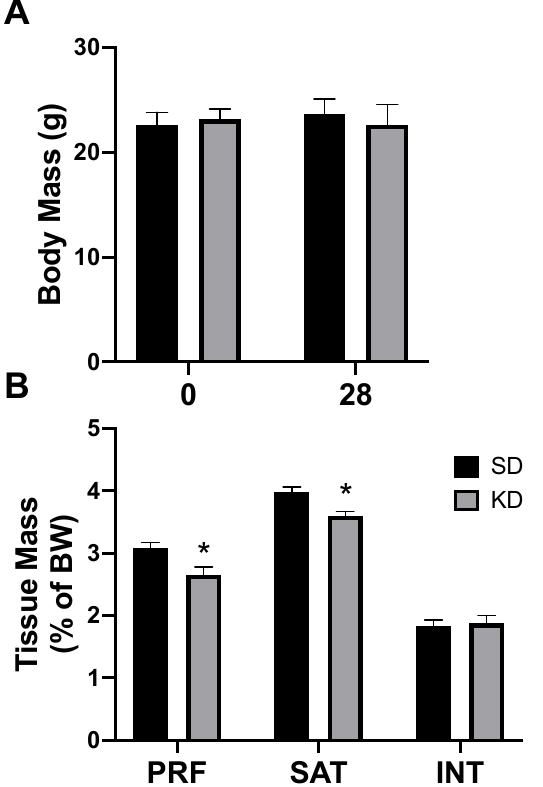
Figure 3. A ketogenic diet selectively alters the fat mass in rodent adipose tissue. Following 28 days on a ketogenic diet (KD) or standard diet (SD), the body mass ( A ) and adipose mass ( B ) from the perirenal (PRF), subcutaneous inguinal (SAT), and interscapular (INT) depots was quantified. n = 6. * p < 0.05.